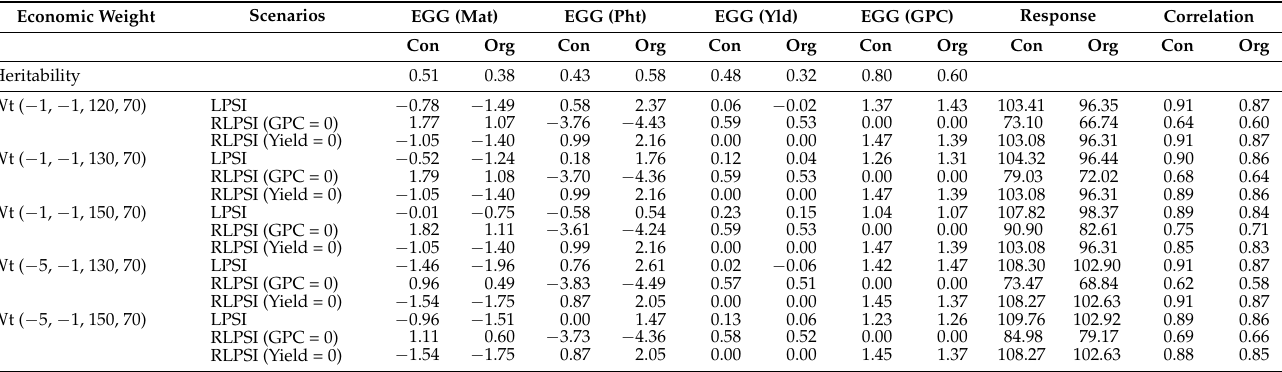
Figure 2. Linear regression plots of the best linear unbiased estimators (BLUEs) computed for each environment ( a – d ) and all environments within the conventional (Con) or organically (Org) management systems ( e , f ). The units of measurement were as follows: grain yield (t ha − 1 ), plant height (cm), maturity ( d ), and grain protein content (%). Table 1. Broad-sense heritability, expected genetic gain (EGG) per trait, response to selection, and correlation between each index and genetic merit based on five economic weights (Wt) and three selection scenarios. The orders of traits in the economic weights were maturity, plant height, grain yield, and grain protein content, respectively. In contrast to the linear phenotypic selection index (LPSI) that did not constrain any trait, the restricted linear phenotypic selection index (RLPSI) constrained the expected genetic gain of either grain yield or GPC to zero. Mat, Pht, Yld, and GPC refer to maturity (days), plant height (cm), grain yield (t ha − 1 ), and grain protein content (%),